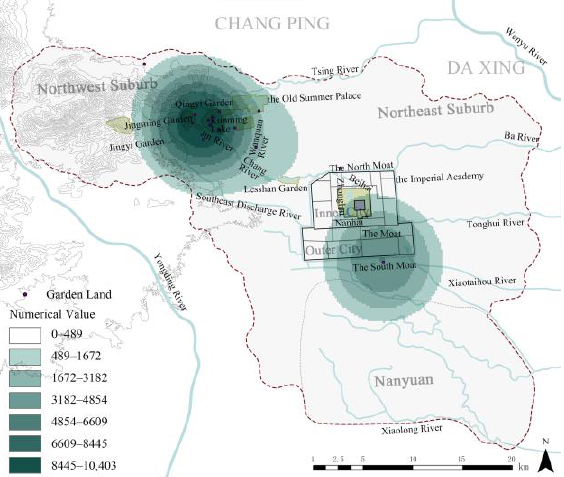
Figure 12. Spatial distribution and density analysis map of garden land.